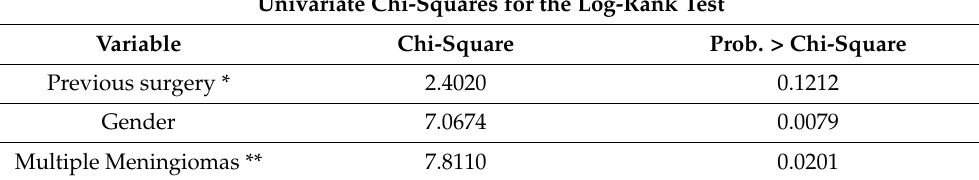
Table 4. Univariate analysis of tumour control defined as stable or reduced volume of the tumour